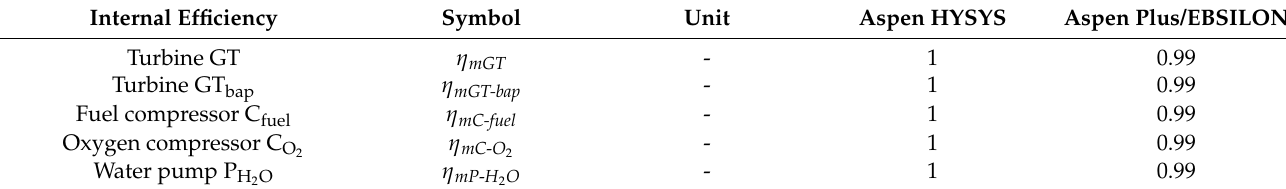
Table 5. Assumed mechanical efficiency—for Aspen Hysys it is impossible to change